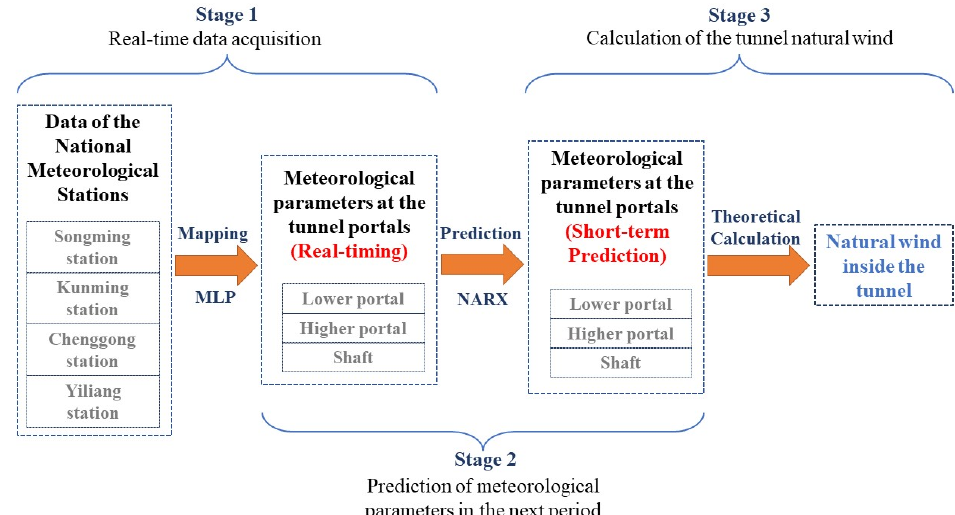
Figure 2. Three stages of tunnel natural wind prediction processes.